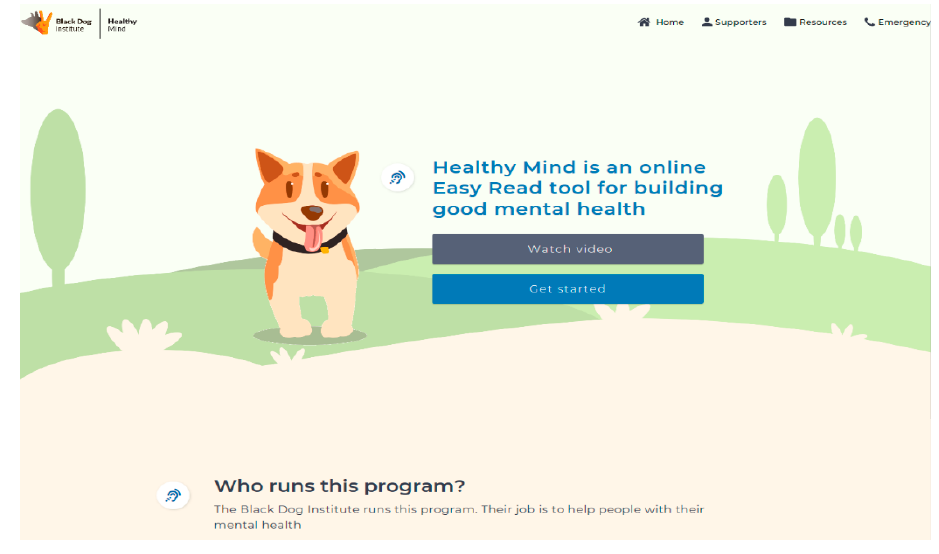
Figure 1. Screenshot of the Healthy Mind landing page.